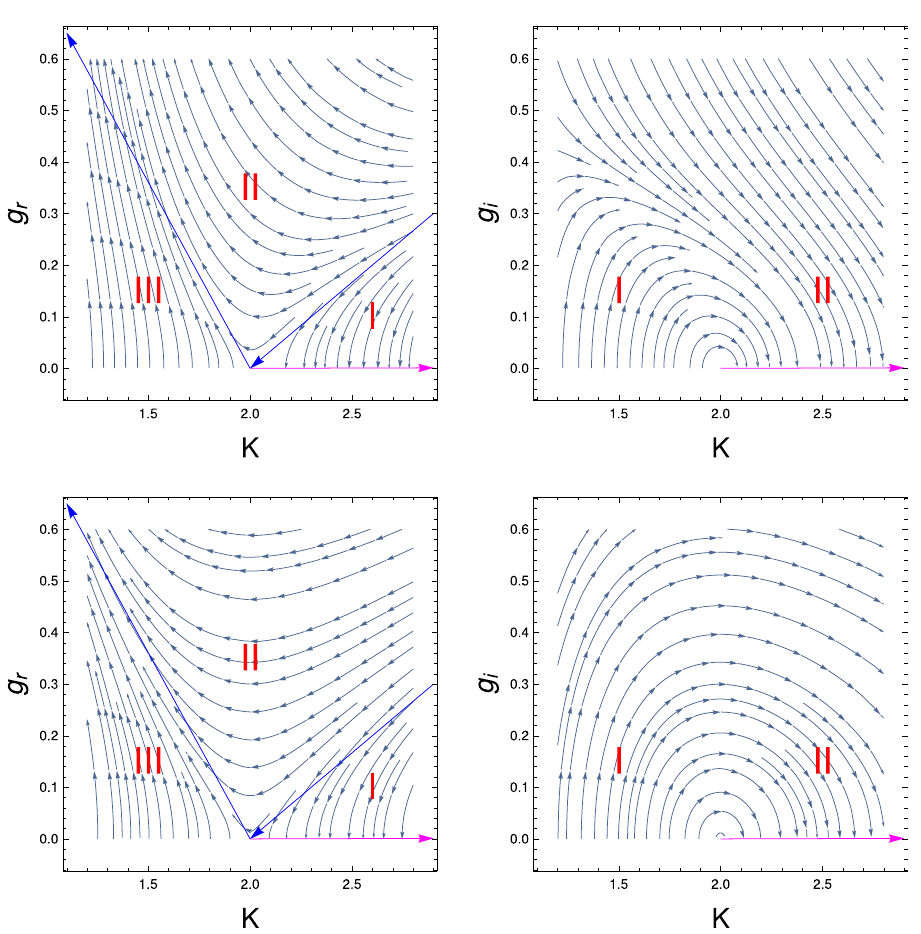
Figure 6. These figures show the behaviour of RG flow lines for the couplings g r and g i to study the conventional quantum BKT equations (Eqs. 7, 8, 9). The upper and lower panels are respectively for third order and second order RG study. We mark different regions of quantum phases by I, II, III and the separatrix by the red colour lines. The magenta colour line represent the fixed line. RG flow lines show different behaviour for the couplings g r and g i and also for the 2nd and 3rd order RG